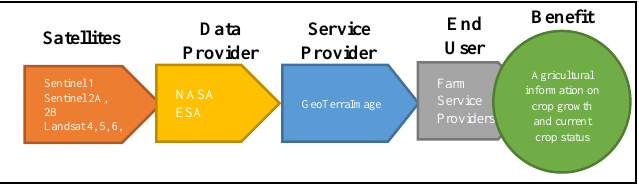
Figure 1: Example of EO value chain in Agriculture (Food